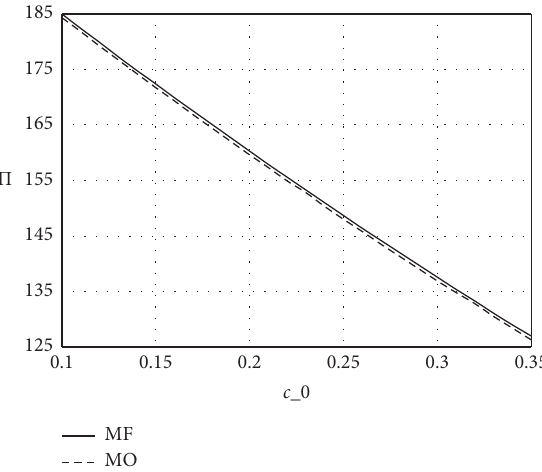
Figure 2: Impact of initial value of unit production cost on manufacturer’s profit.